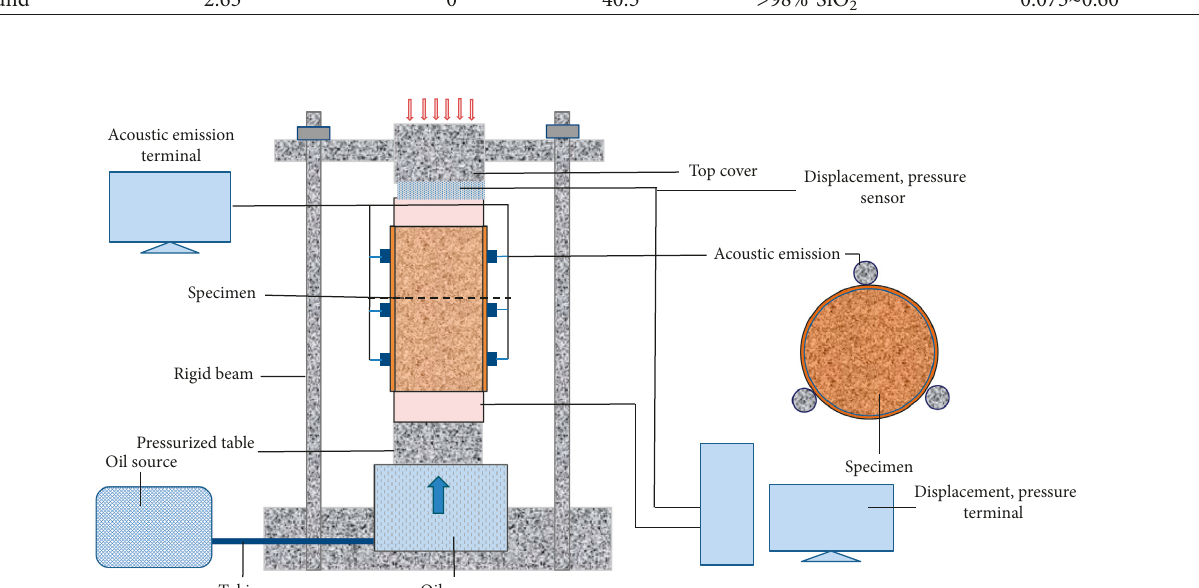
Figure 1: The UCS test of MCS material.